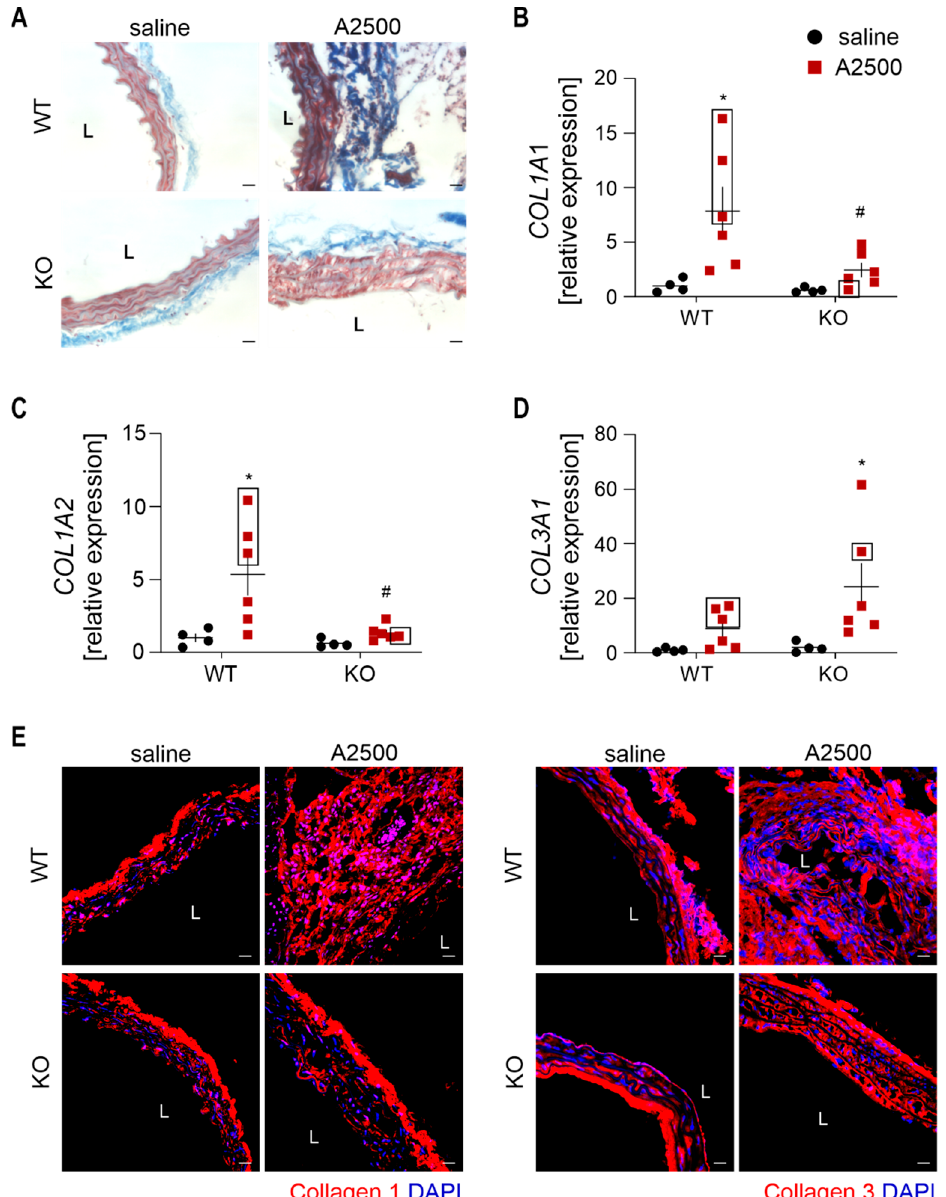
Figure 8. Differential effect on the collagens upon AngII infusion between the genotypes. The mice were infused with either saline or angiotensin II at the dose 2500 ng/kg/min using the osmotic pumps for 14 days. ( A ) Trichrome staining in the abdominal aorta; Representative images, magnification 400x; ( B – D ) Relative expression of ( B ) COL1A1 ; ( C ) COL1A2 ; and ( D ) COL3A1 in the abdominal aortic wall. eEF2 was used as a reference gene. Two-way ANOVA with Tukey’s post hoc test; * p < 0.05 vs. saline, # p < 0.05 vs. WT. Rectangle—mice which developed the aneurysm; ( E ) Immunofluorescent staining of collagen I and collagen III within the abdominal aorta. L—lumen. Collagen—red, nuclei—blue. Representative images. Scale bar 30 µm.